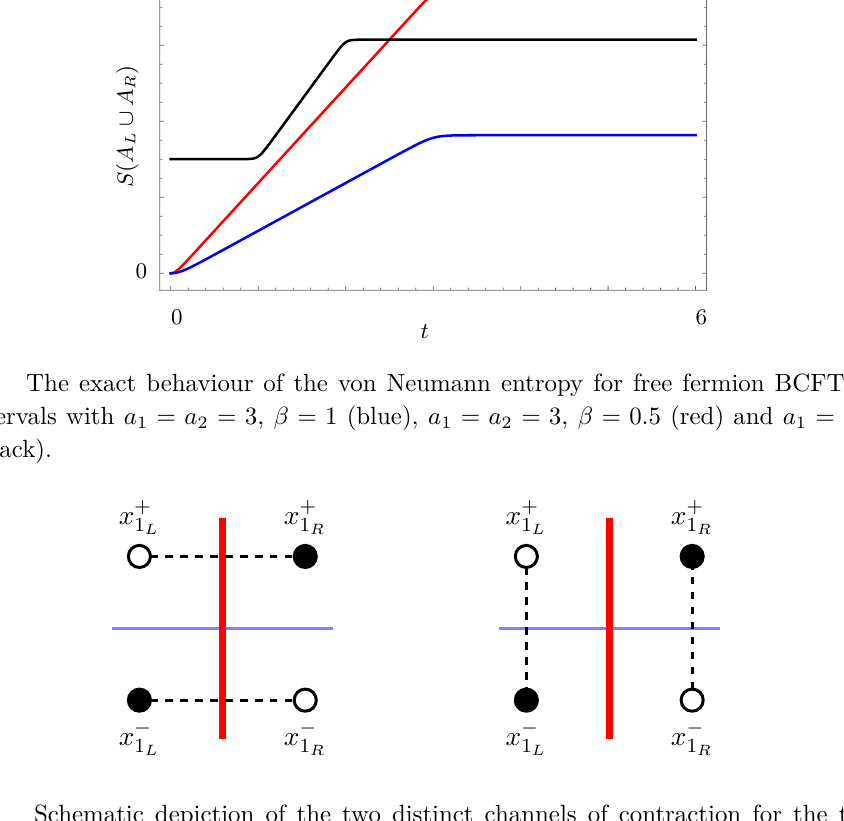
Figure 5 . Schematic depiction of the two distinct channels of contraction for the twist-anti- twist correlator in BCFT. The panel on the right yields the disconnected contribution given by the product of the one-point function of twist fields on the half-plane (in the Euclidean picture). Solid and hollow dots distinguish twist and anti-twist operator